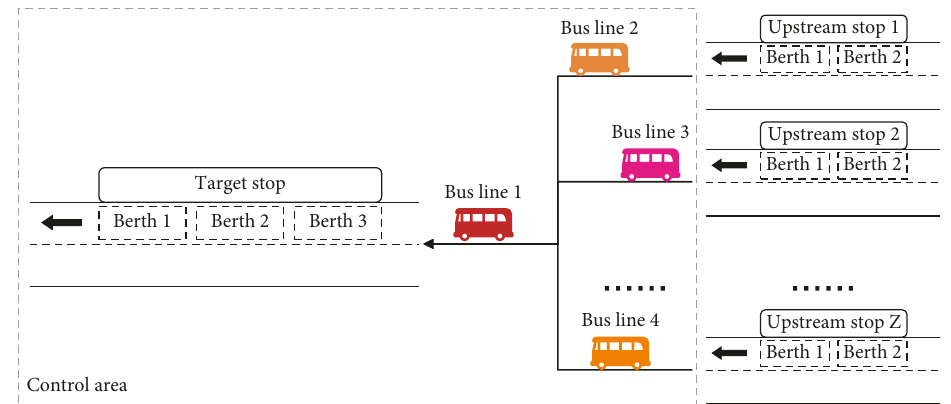
Figure 2: Target bus stop with multiple upstream stops and bus lines.